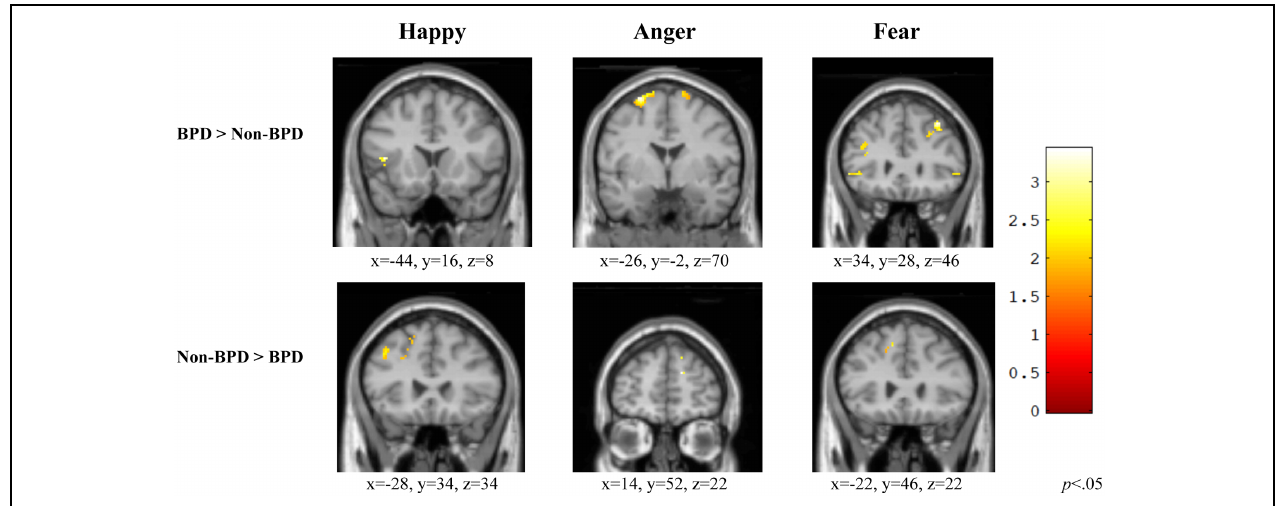
FIGURE 2 | Group comparisons of Frontal ROI activity in three affective categories. Within the frontal ROI, individuals with BPD demonstrated a different pattern of activation relative to those without BPD and tended to display greater activation within the ROI relative to those without BPD. BPD, borderline personality disorder; Non-BPD, No